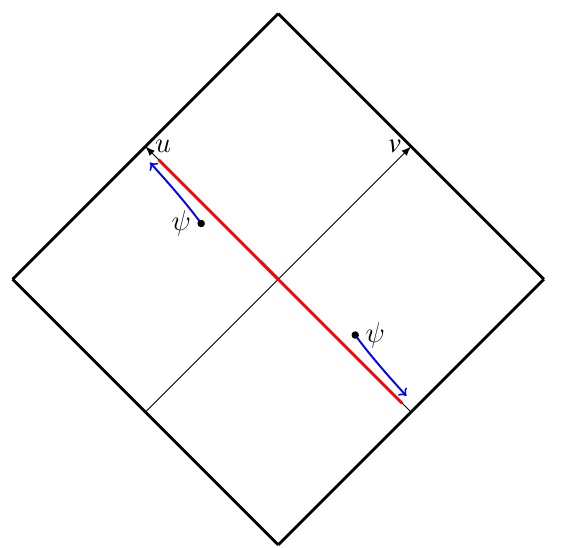
Figure 2 . In the Regge limit the leading correction to the OPE is the graviton h uu integrated over the red line.